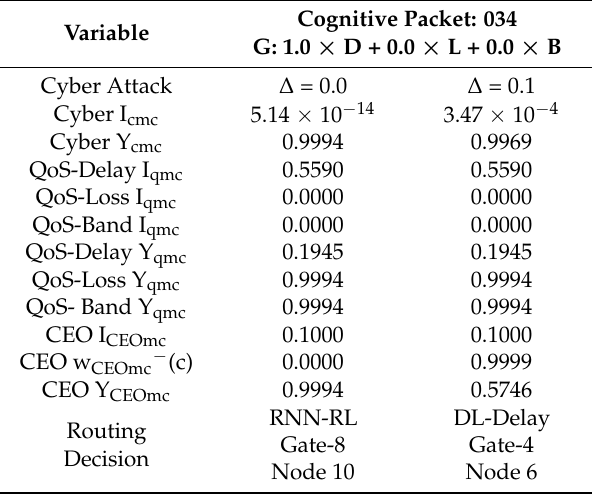
Table 18. DL Management Cluster Validation (5 × 5